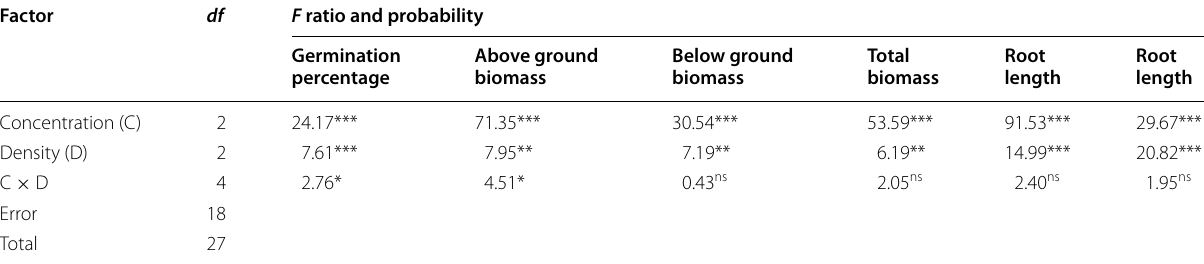
Data used as % of control. Level of significance: ***, **, * and ns indicate significant difference at P